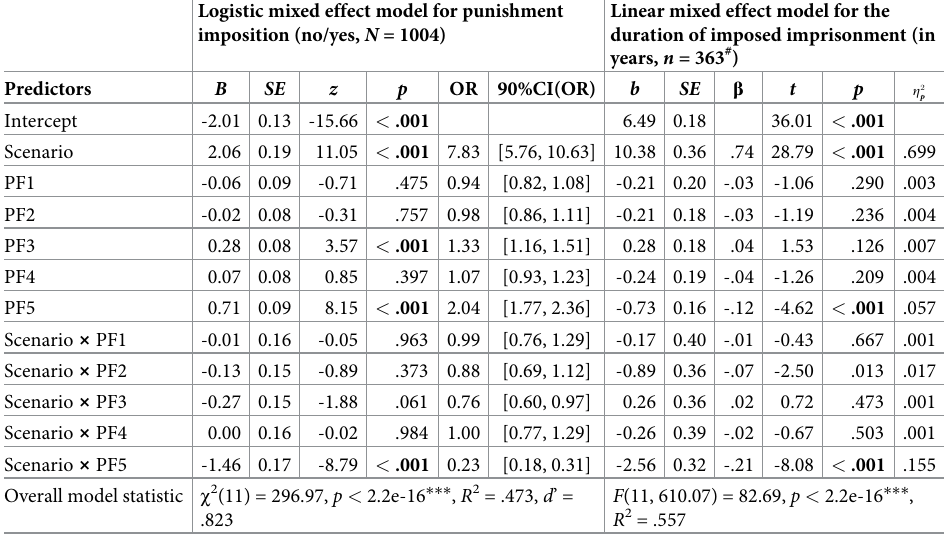
Table 3. Results of logistic and linear mixed effect regressions for punishment imposition and severity. Logistic mixed effect model for punishment Linear mixed effect model for the imposition (no/yes, N = 1004) duration of imposed imprisonment (in